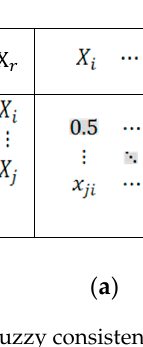
Figure 5. Fuzzy consistent matrices of downstream sensitivity ( a ) and probability of change ( b ).